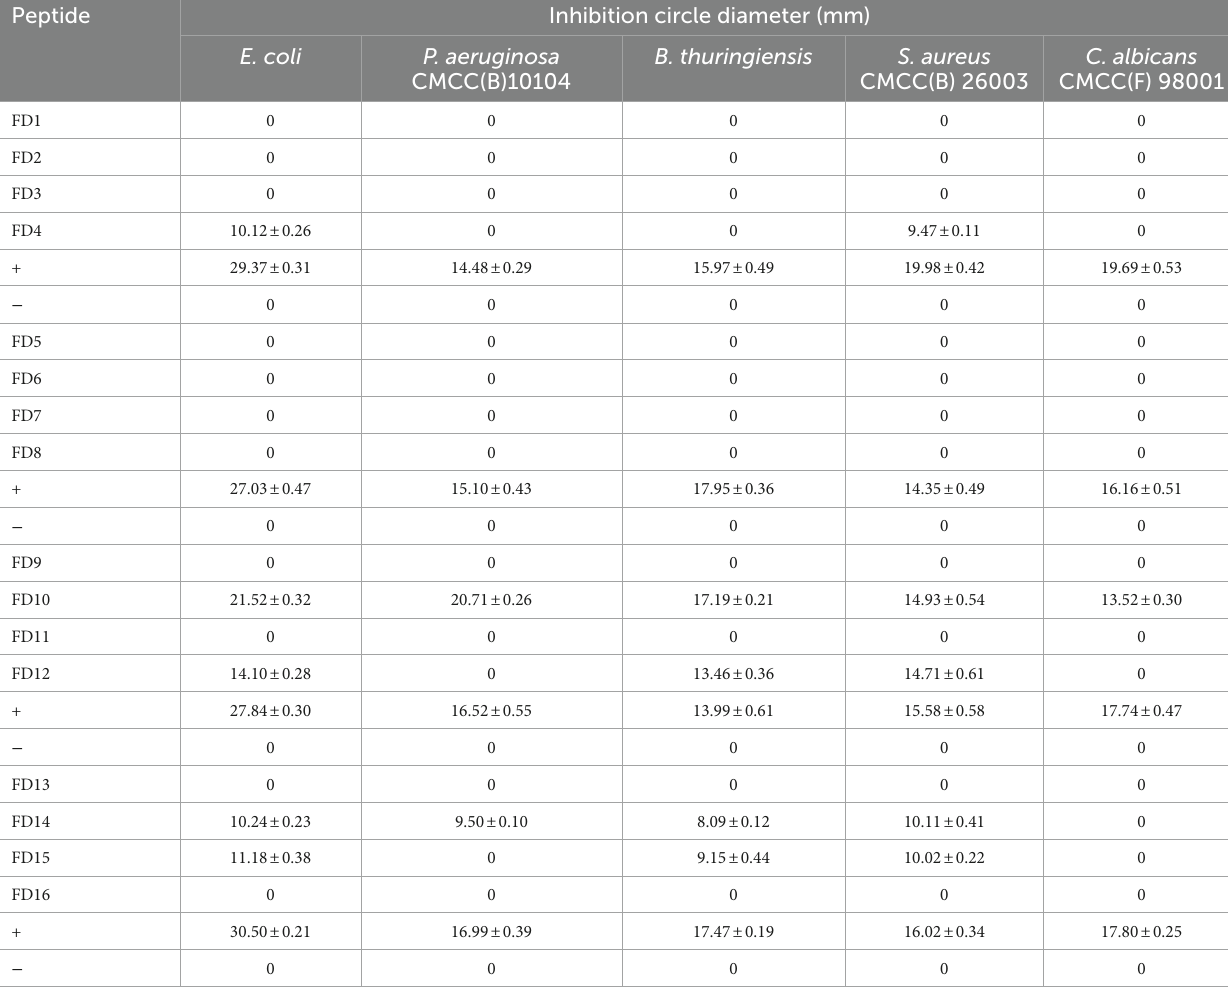
TABLE 3 Diameter of the inhibition zone of 16 peptides.